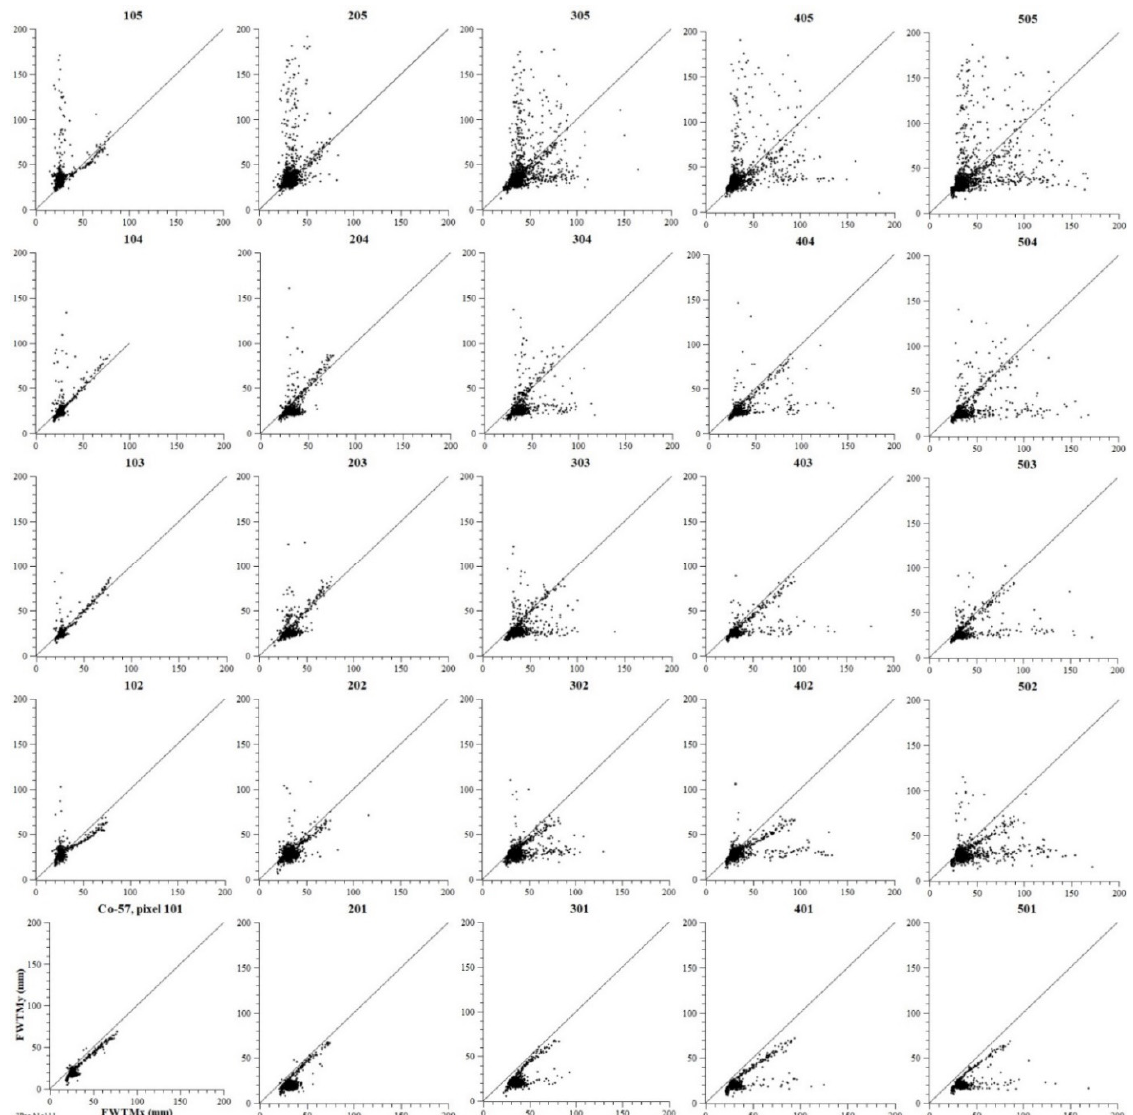
Figure A7. FWTMy vs. FWTMx scatter-plots per pixel for the first quarter of crystal-array under Co-57 point-source irra- diation. The first quarter includes the pixels with RR ≤ 5 and CC ≤ 5. The axes titles and the plots descriptions, suitable for all the frames of the figure, are reported only once in the bottom-left frame. The scatter-plots, obtained from single-events values, are reported together with the bisector of the semi-plane as a reference.